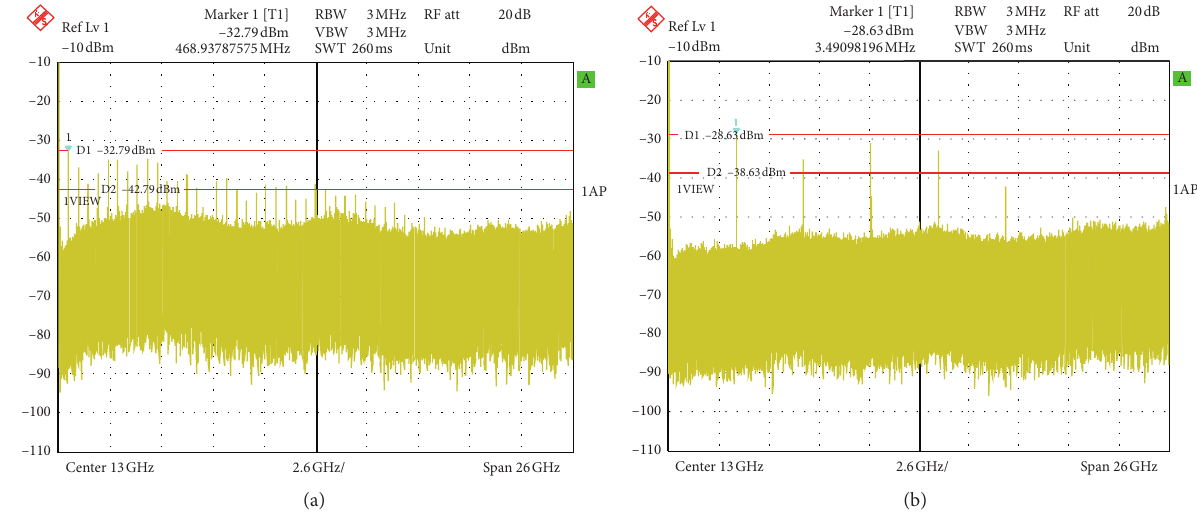
Figure 4: Generated MFC when the modulation frequency is 0.5GHz (a) and 3.5 GHz